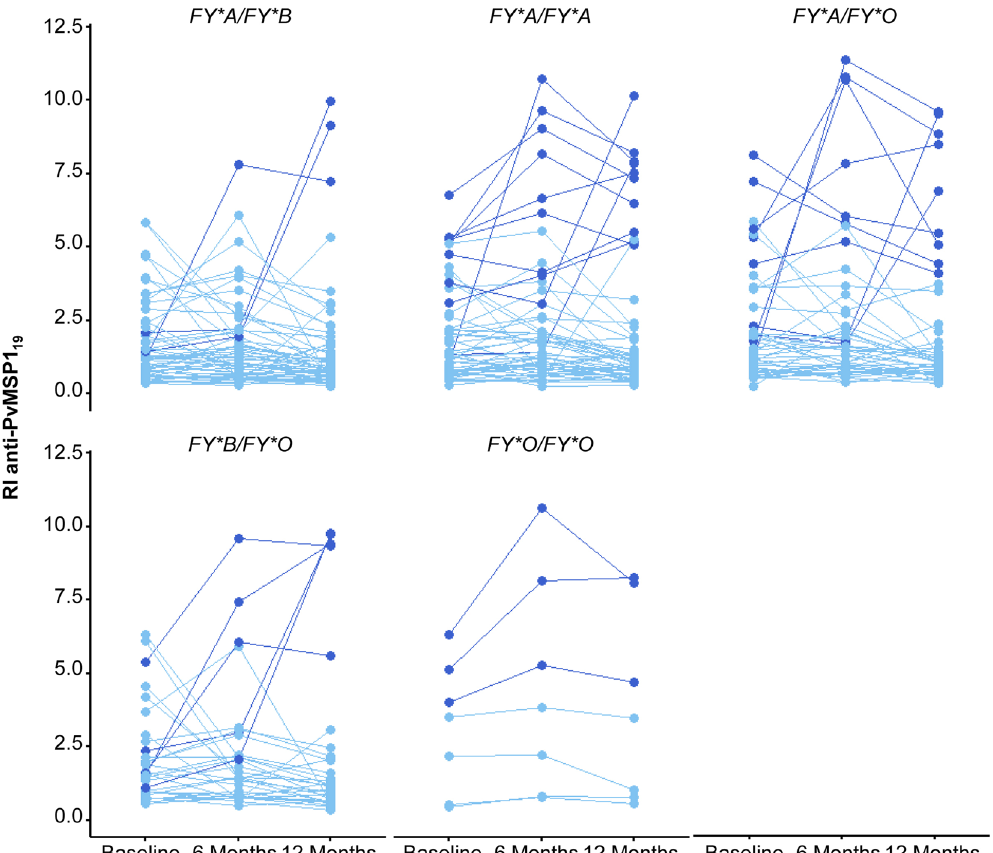
Figure 6. Individual anti-PvMSP1 19 response evaluated in three cross-sectional surveys (baseline, 6 months and 12 months) according to the DARC genotype. The results were expressed as the reactivity index (RI). The antibody response data for low- and high-response groups are colored by light blue and dark blue,